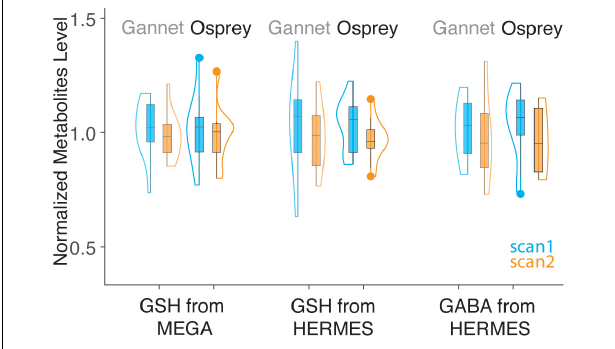
FIGURE 4 | Violin plot of GSH and GABA+ estimates from simple peak fitting in Gannet and LCM in Osprey, grouped by sequence. Values for Gannet ( n = 12 for HERMES, n = 11 for MEGA) and Osprey ( n = 12 for HERMES, n = 11 for MEGA) have been normalized so that the mean of all values is 1, for the purposes of overlay. Note the greater variance of GSH_HERMES data using Gannet compared to Osprey (pairwise F -tests were used to assess the variance difference between methods). TABLE 2 | Within-subject CVs of HERMES and MEGA-PRESS data modeled by